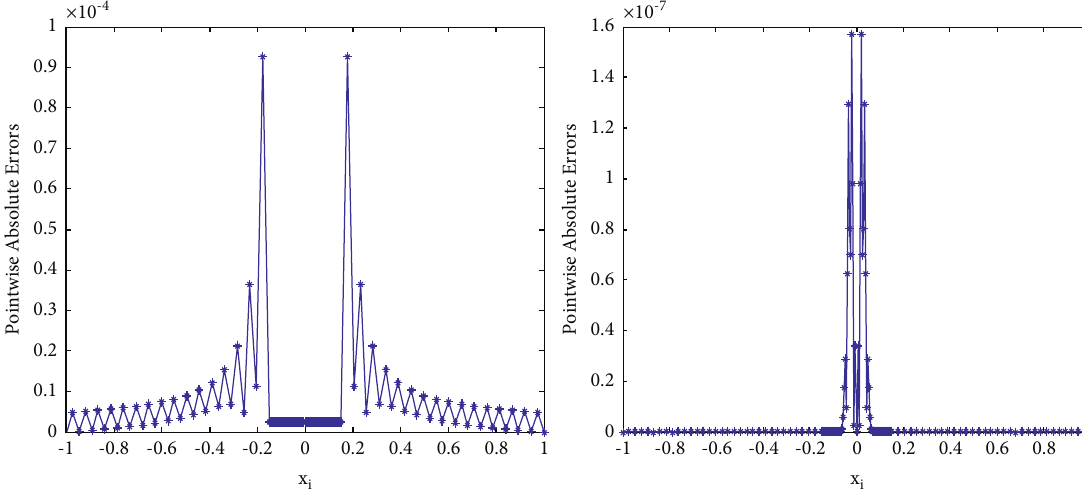
Figure 2: Point wise absolute errors for Examples 1 and 2 respectively, when ε � 2 − 12 and N �